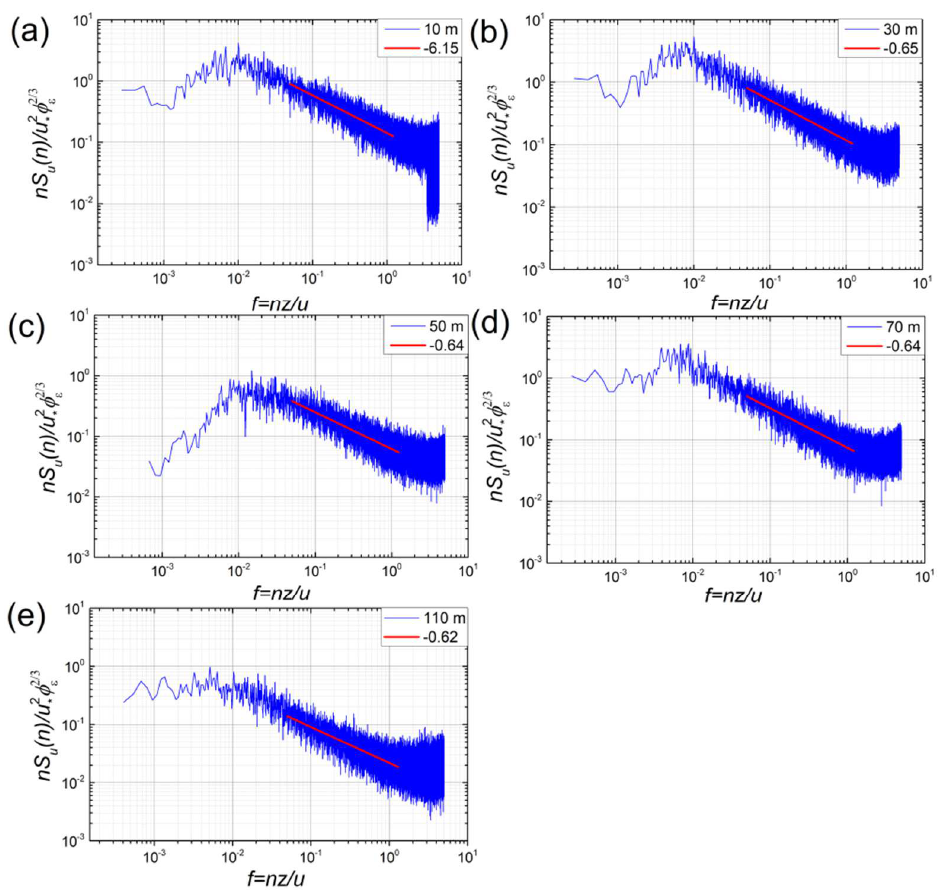
Figure 3. Normalized logarithmic along-wind spectrum plotted against the non-dimensional fre- quency, f = n(z)/u at ( a ) 10 m, ( b ) 30 m, ( c ) 50 m, ( d ) 70 m, and ( e ) 110 m. Short red solid lines indicate the along-wind spectrum of slopes for the inertial subrange. Twenty hertz raw data were for Typhoon Maria (2018) from 0000 local standard time (LST) 10 July to 0000 LST 12 July 2018. Cospectra analyses of the measured turbulent fluctuations are a useful tool for testing